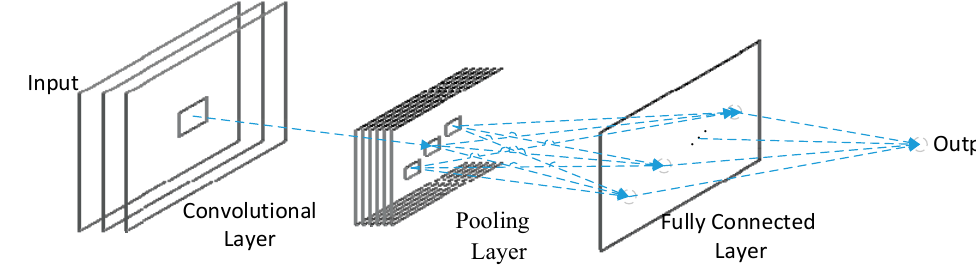
Figure 1. The structure of a convolutional neural network (CNN).